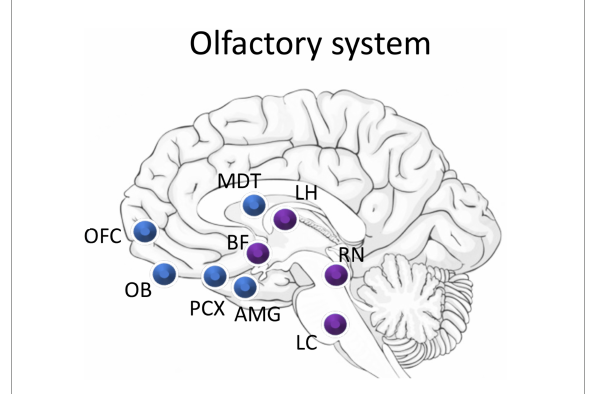
FIGURE2 Schematic of major olfactory system components (blue) and overlap with sleep related areas (purple). Odor information flows from the olfactory bulb (OB) to the piriform cortex (PCX). PCX direct projection targets include the mediodorsal nucleus of the thalamus (MDT), the orbitofrontal cortex (OFC), the amygdala (AMG), and regions of the lateral hypothalamus (LH). The olfactory system receives strong neuromodulatory input from the cholinergic basal forebrain (BF), serotonergic raphe nucleus (RN), and the noradrenergic locus coeruleus (LC). Importantly, neurons in the LH, BF, and LC have all been shown to also be odor